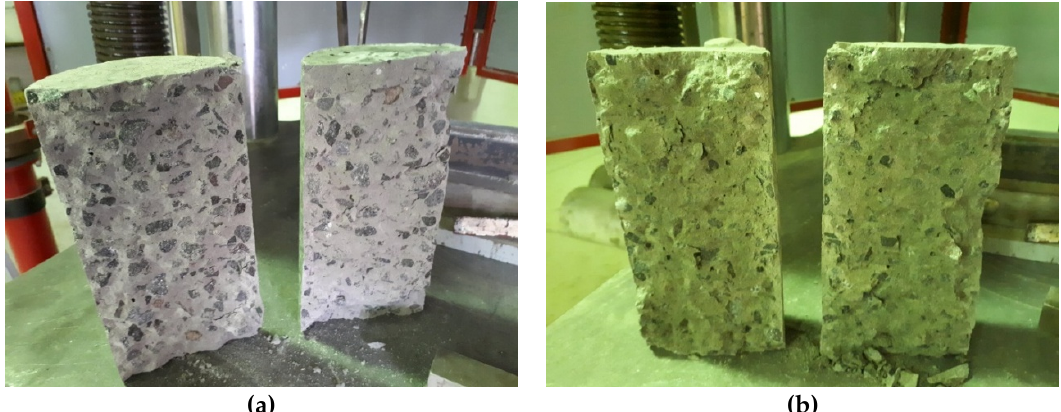
Figure 16. ( a , b ) Vertical shear failure of samples subjected to compression testing.